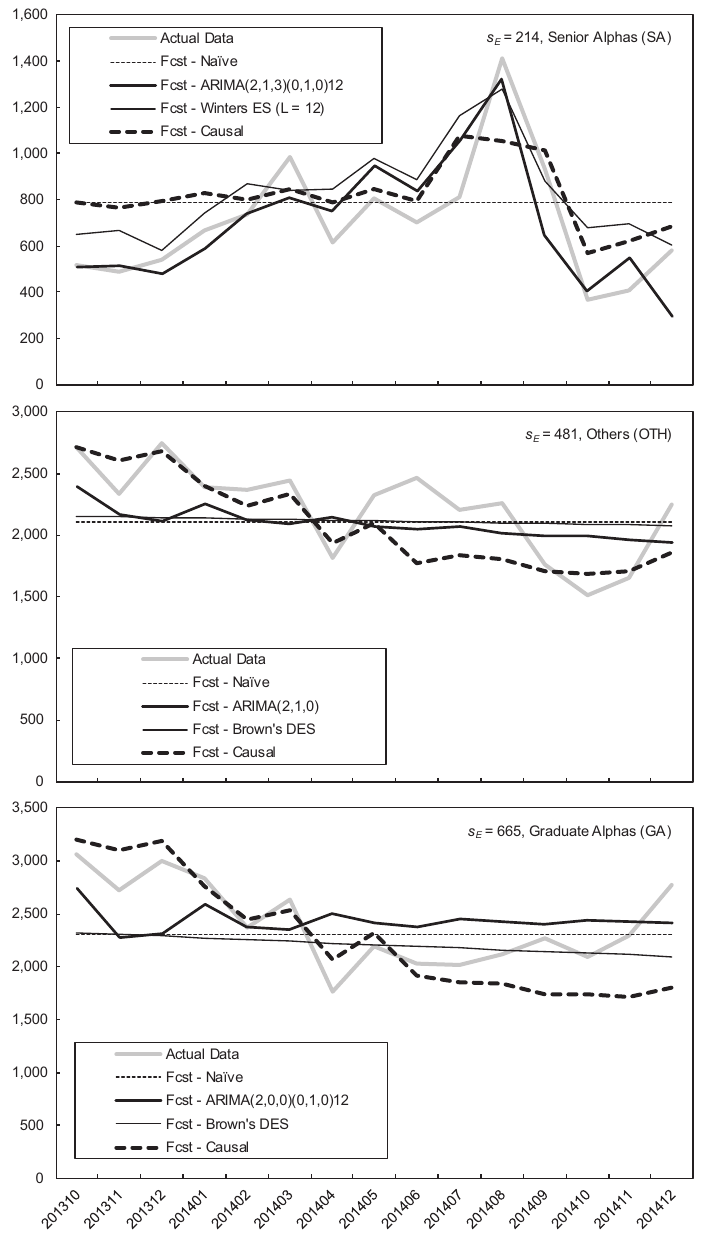
Figure 6. Forecasts of